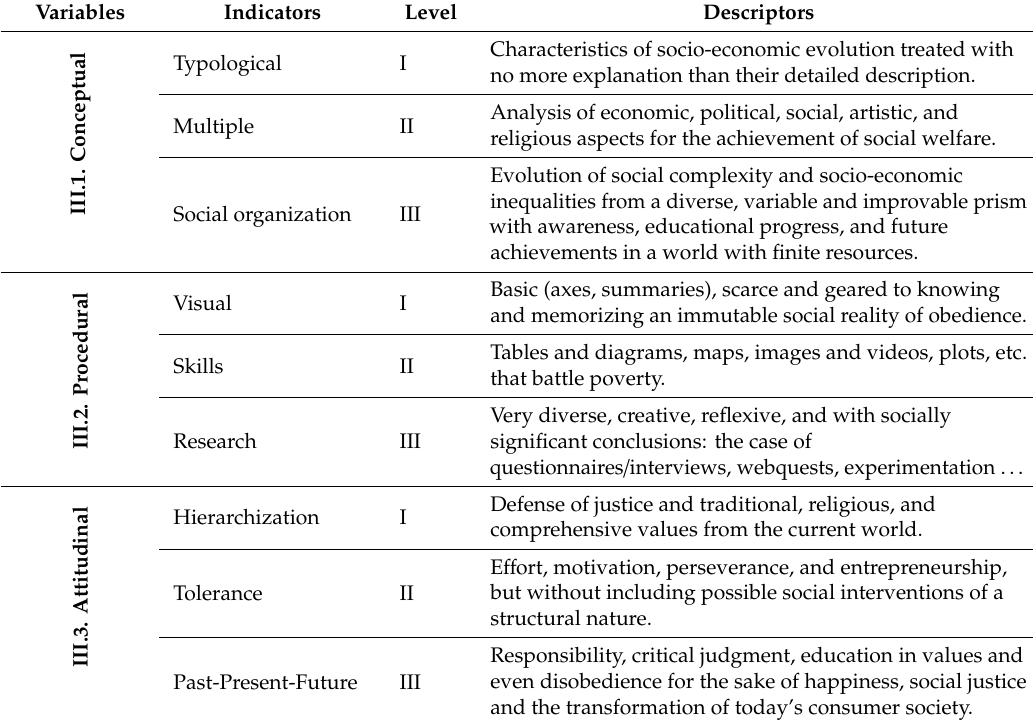
Table 6. System of categories by levels of complexity ( Category: III. Contents